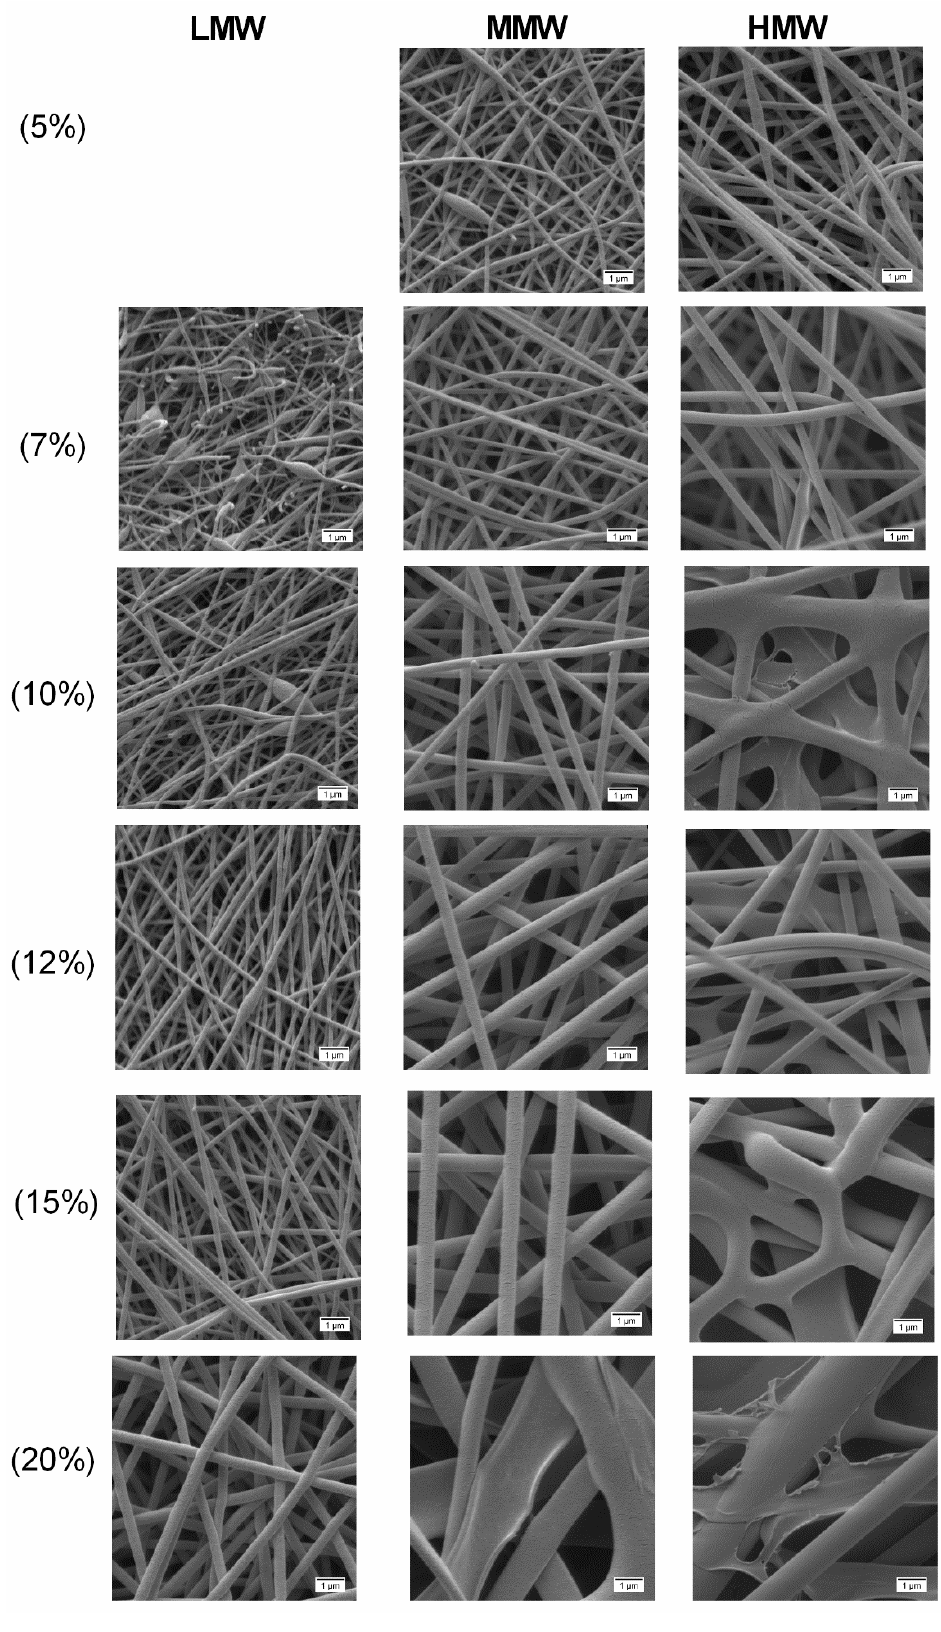
Figure 5. SEM images at 10,000 × showing the obtained electrospun fibers from pure PVA polymer solutions. All scale bars represent 1 µm.